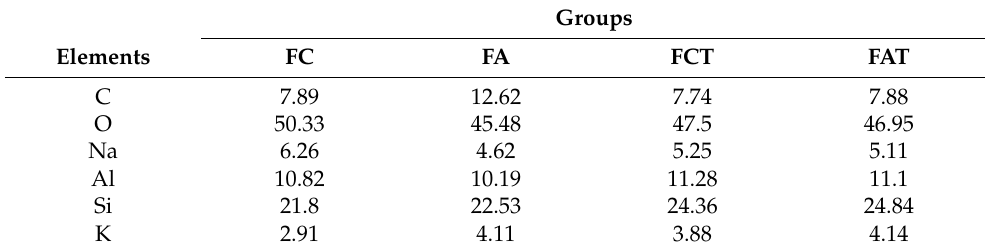
Table 2. Elemental composition (% wt) of the surface of the test groups.